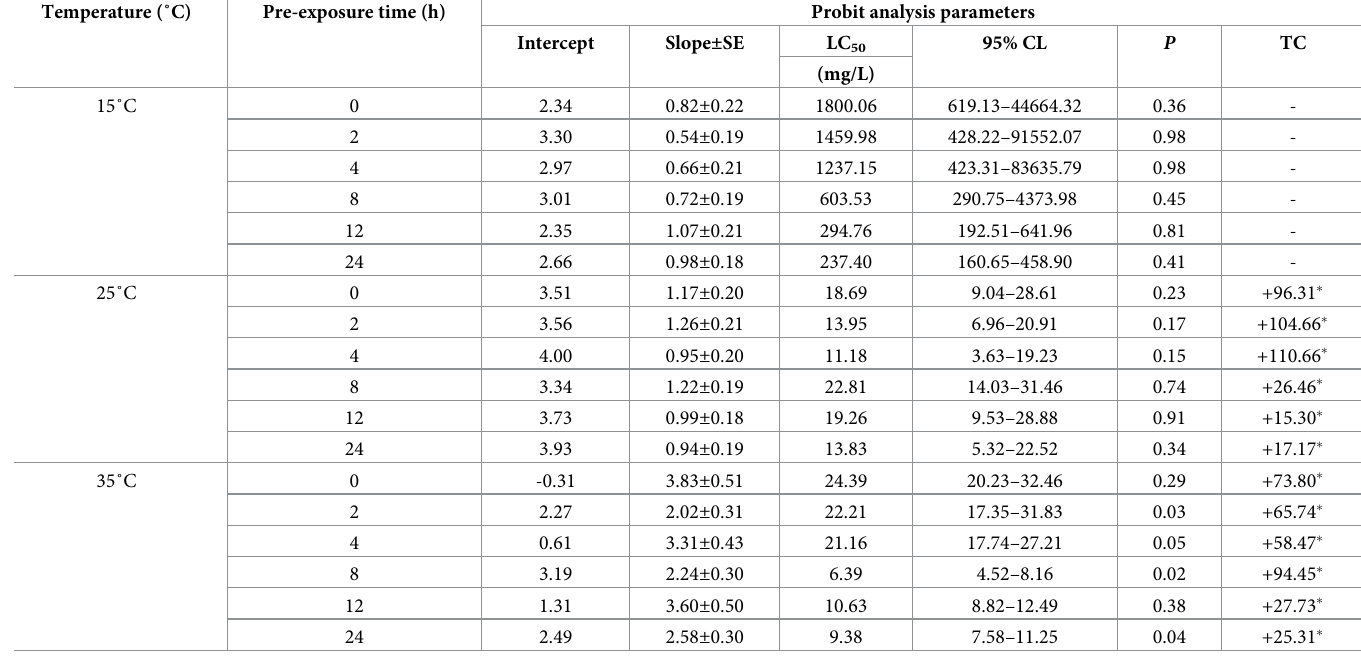
Table 1. Influence of pre-exposure time on the toxicity of positive temperature effect insecticide hexaflumuron to A . lucorum at 15, 25, 35˚C. Temperature (˚C)